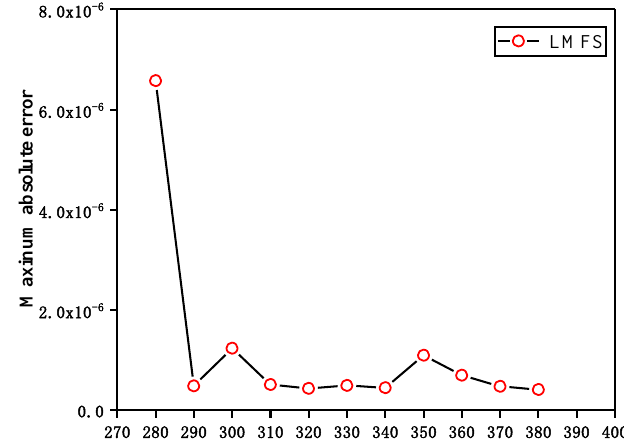
Figure 12. The convergence rate of local nodes.